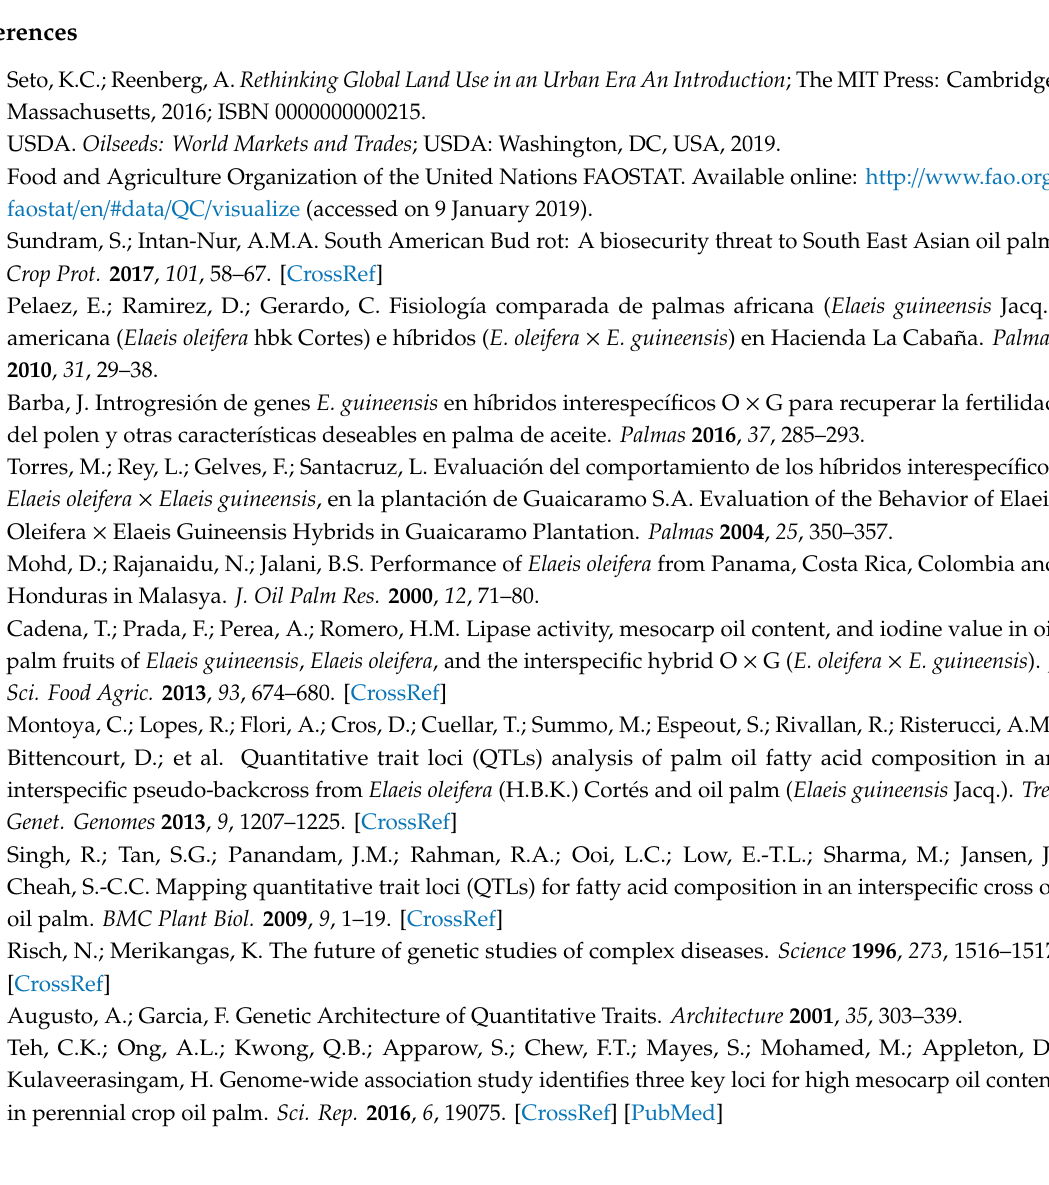
clusters used to explain our population structure, Table S2: List of the 62 Candidate Genes (CG) targeted by SNP which were used for the Association Mapping studies in oil palm hybrids, Figure S2: Quantile-Quantile plots of the di ff erent studied traits for the four tested models, Table S3: Characteristics of all 171 candidate genes initially analyzed by Amplicon sequencing in oil palm hybrids, Table S4: Raw phenotypic data from for each genotype, Table S5: Universal adapters and MID sequences used for generating barcoded amplicons of the di ff erent Candidate Genes